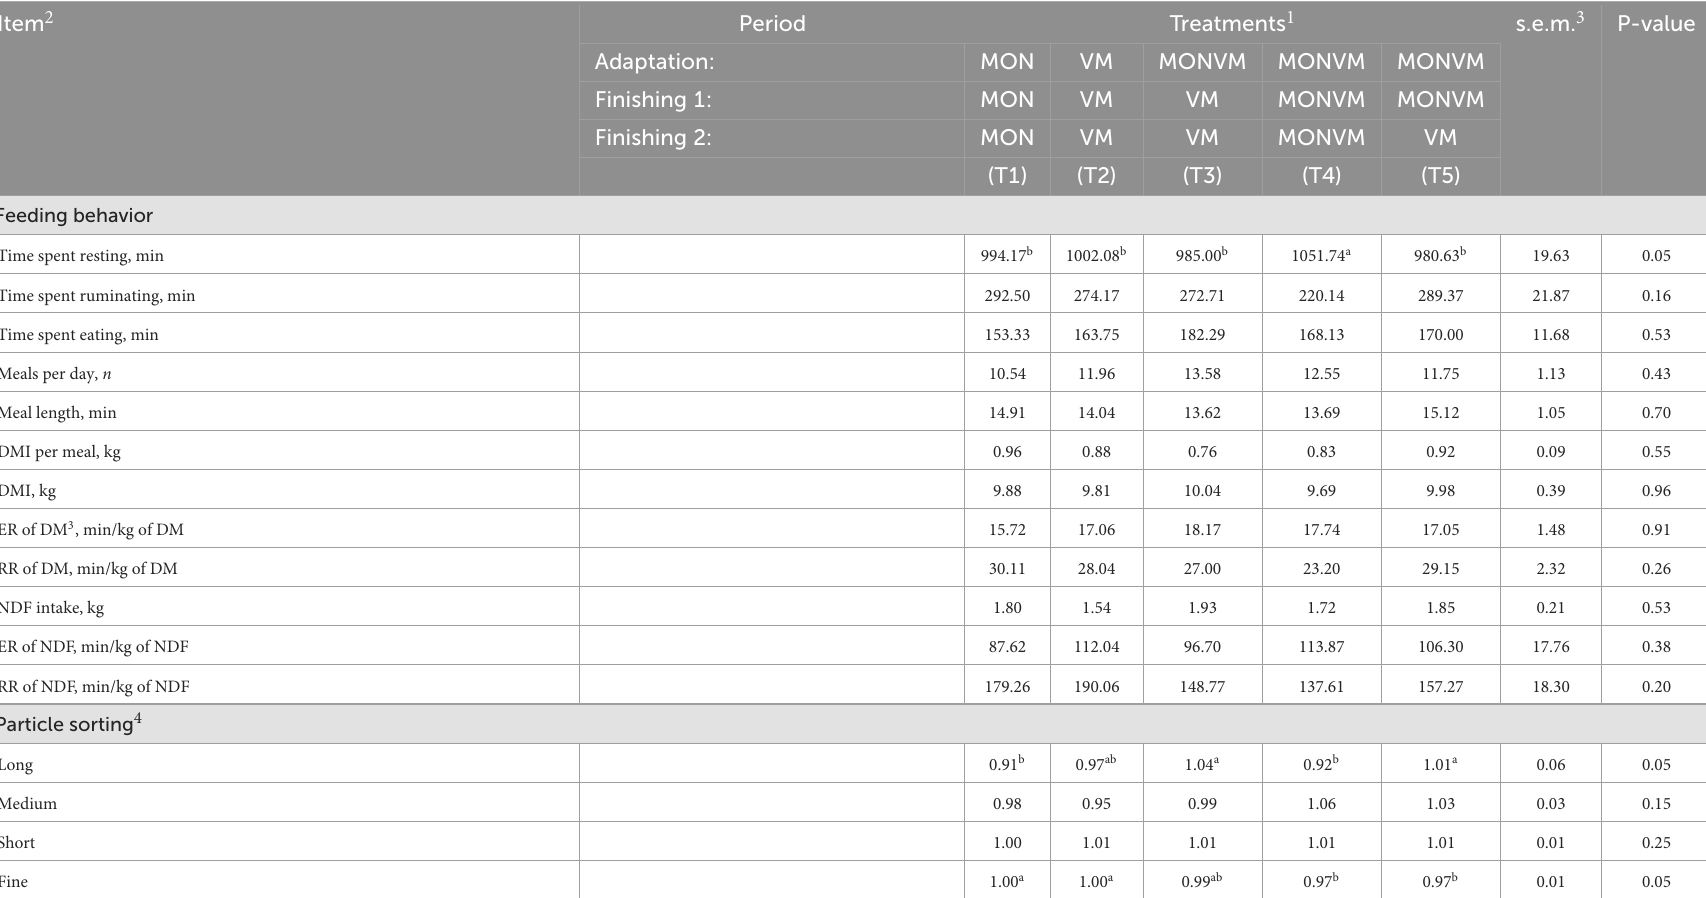
TABLE 4 Withdrawal of sodium monensin when associated with virginiamycin during adaptation and finishing periods on feeding behavior and particle sorting at day 61 (finishing period 1) of Nellore yearling bulls ( n = 30) consuming high-concentrate diets. Item 2 Period Treatments 1 s.e.m. 3 P-value Adaptation: MON VM MONVM MONVM